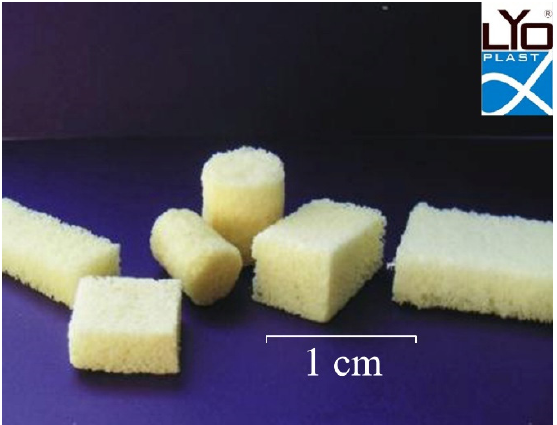
Figure 1. Samples of demineralized lyophilized human spongiosa Lyoplast ® . Experimental samples of Lyoplast ® material underwent compulsory low-frequency ultrasonic treatment using ultrasonic bath “Sapphire” TTC (RMD), (Sapphire LTD, Moscow, Russia with a frequency of 24–40 kHz.